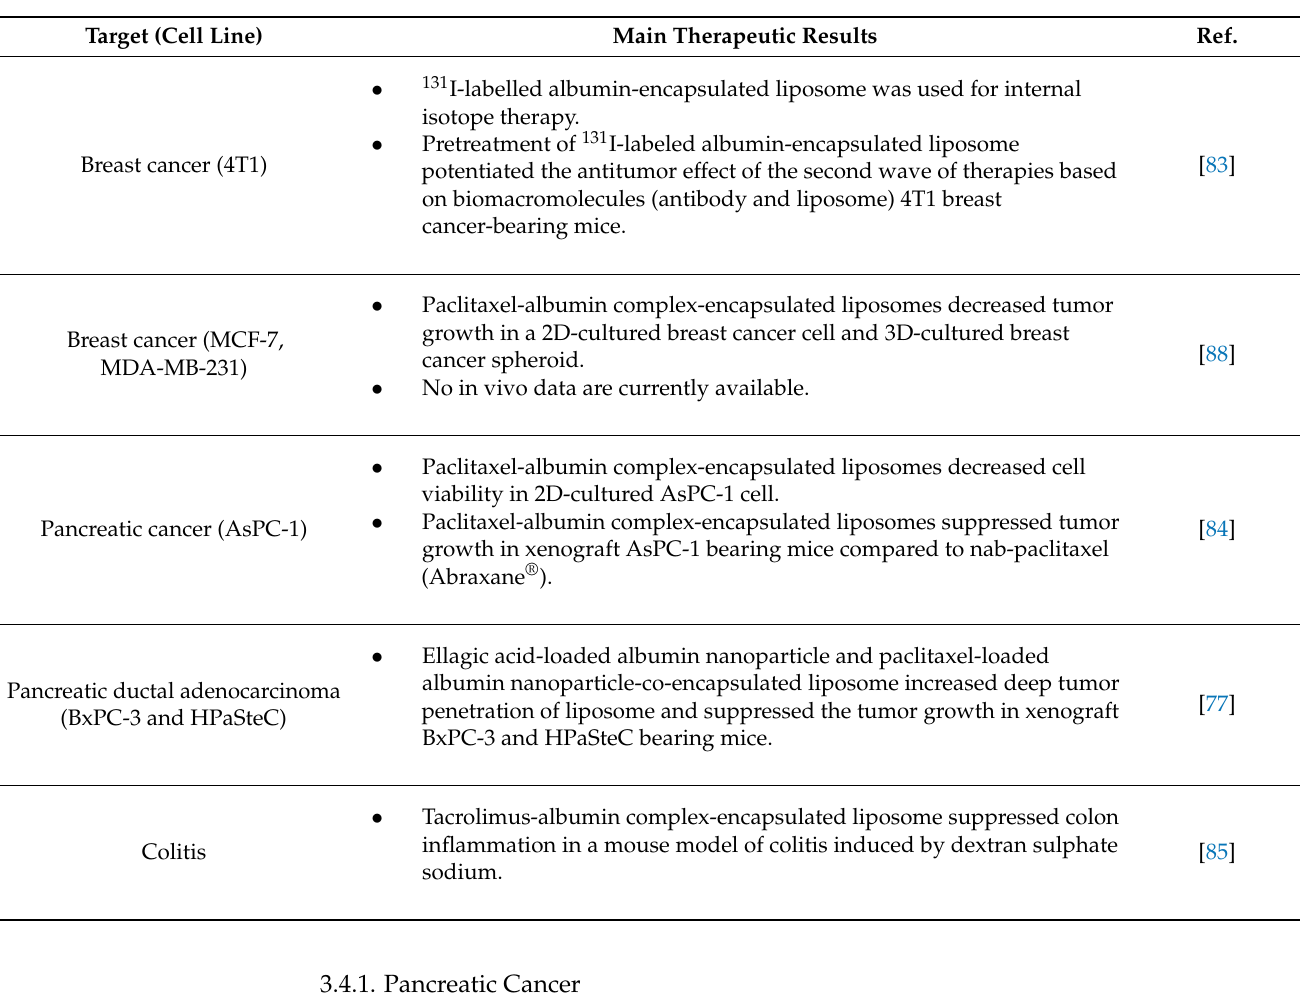
Table 1. Cont . Main Therapeutic Results